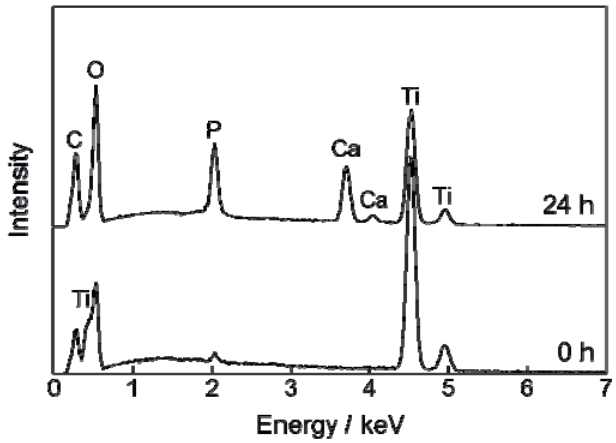
Figure 2. EDX spectra of the surfaces of Ti pins before (0 h) and after (24 h) immersion in the CaP solution at 25 °C for 24 h.